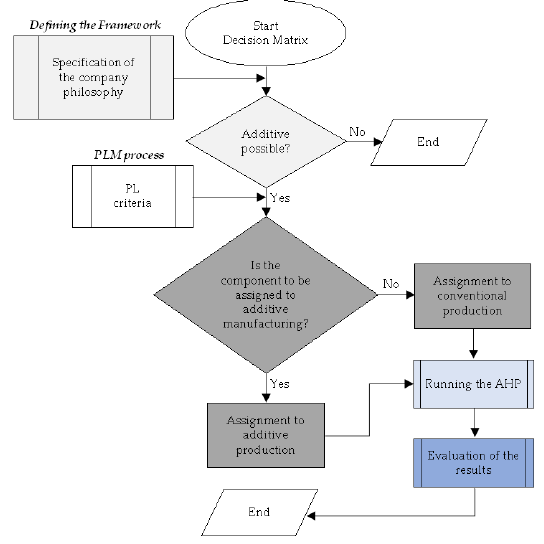
Figure 3. Function flowchart of the decision matrix, including all layers.